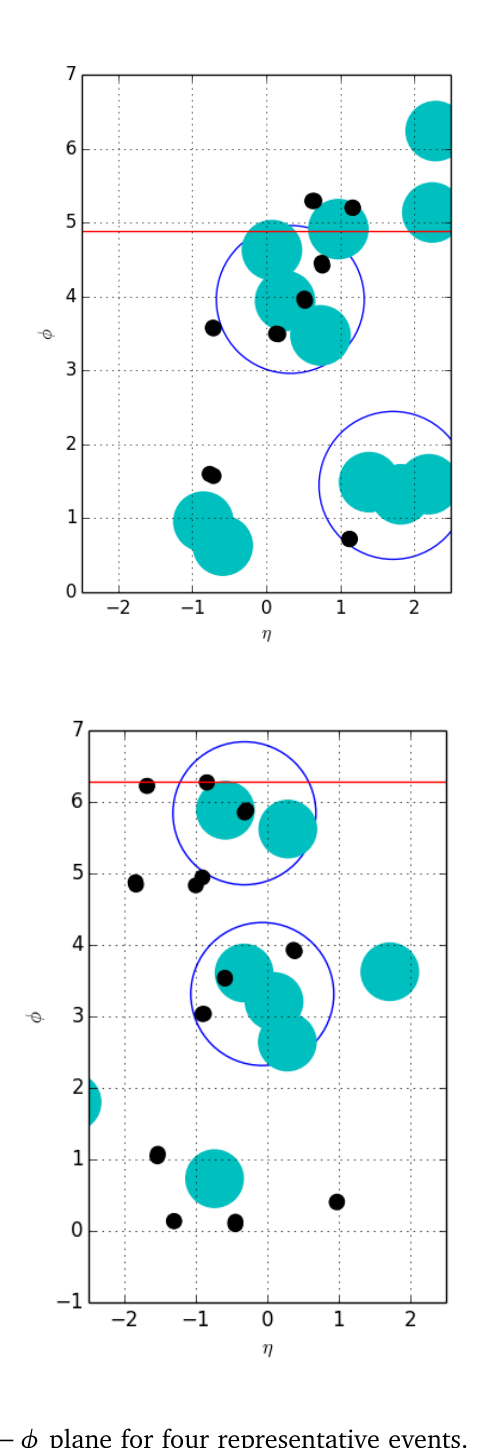
Figure 4: Various objects are plotted in η − φ plane for four representative events. The large hollow blue circles represent the trimmed large-radius jets, the filled cyan circles represent anti- k jets with R = 0.4, the black points represent dark hadrons, t and the red line the direction of missing transverses